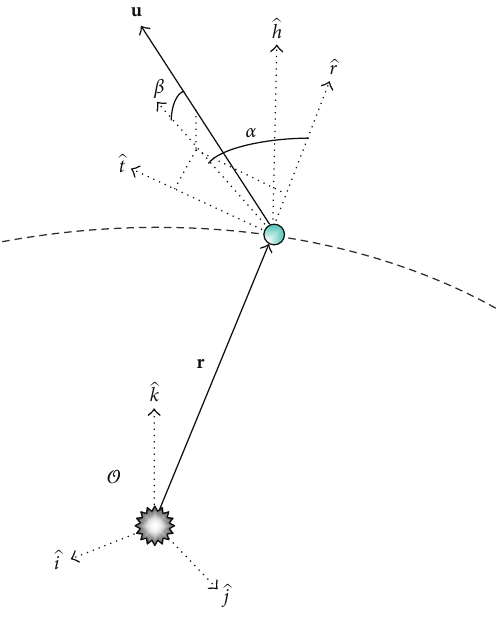
Figure 18: 18 Radial-transverse reference